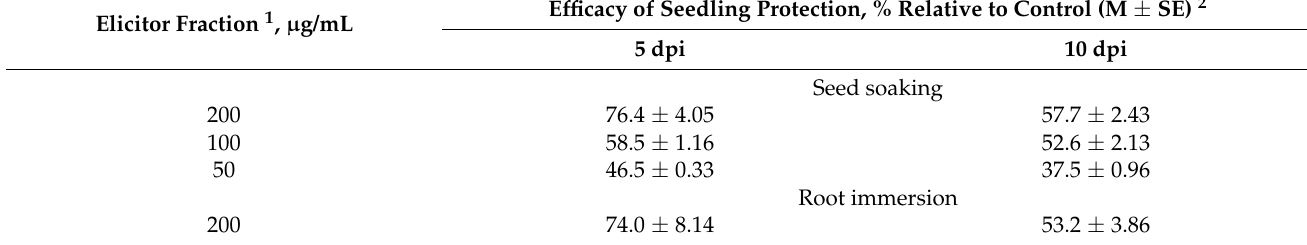
Table 1. Protective effect of FS-94 elicitors against Fusarium wilt of tomato.